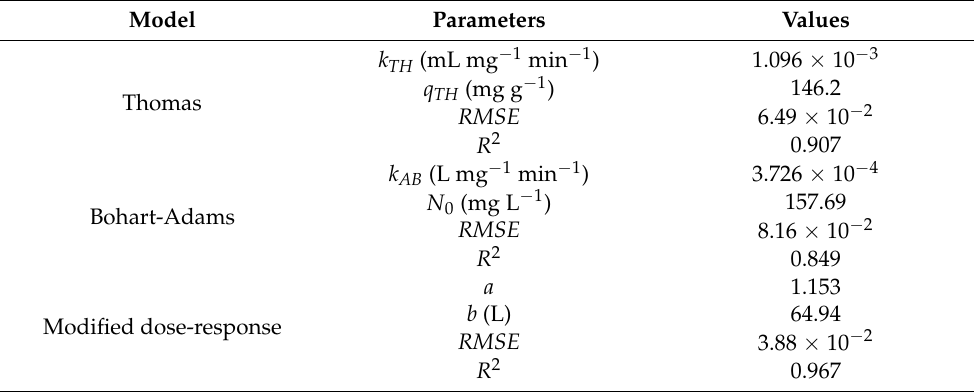
Table 4. Model parameters obtained by non-linear regression analysis for column studies.